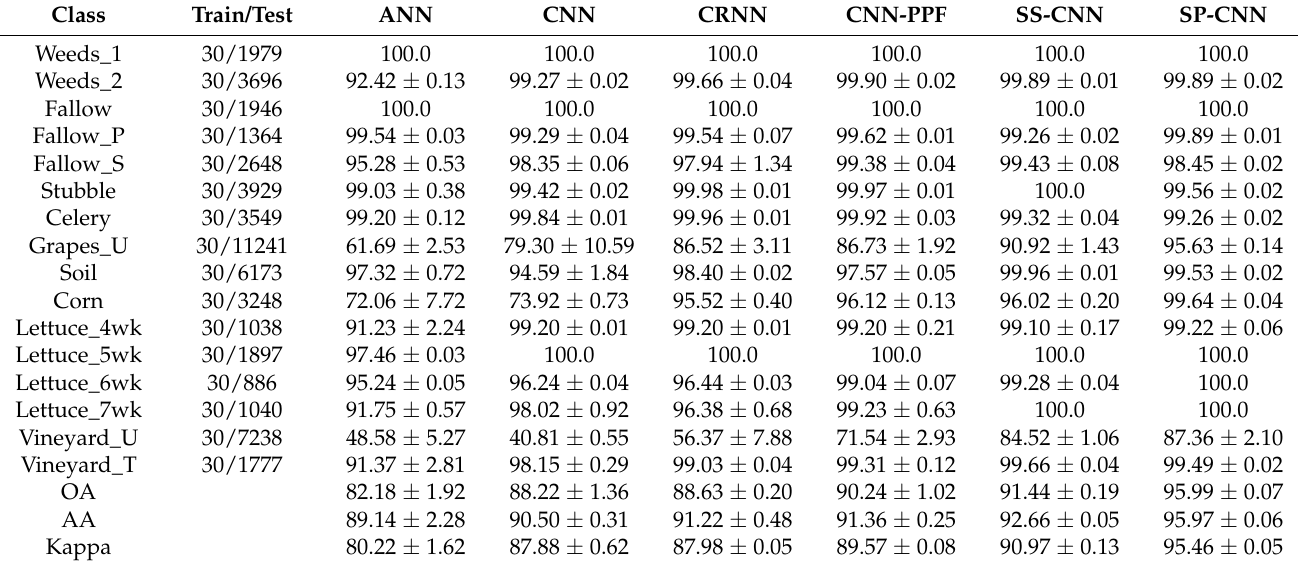
Table 4. Summary of classification results of six classifiers on Salinas